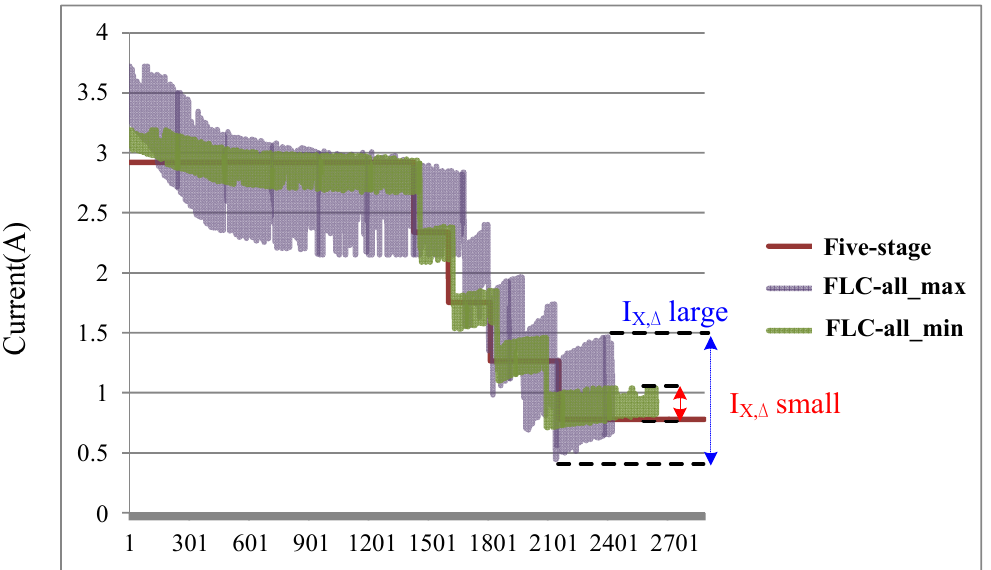
Figure 4. Experiment results of two FLC-based battery controllers with different output MF